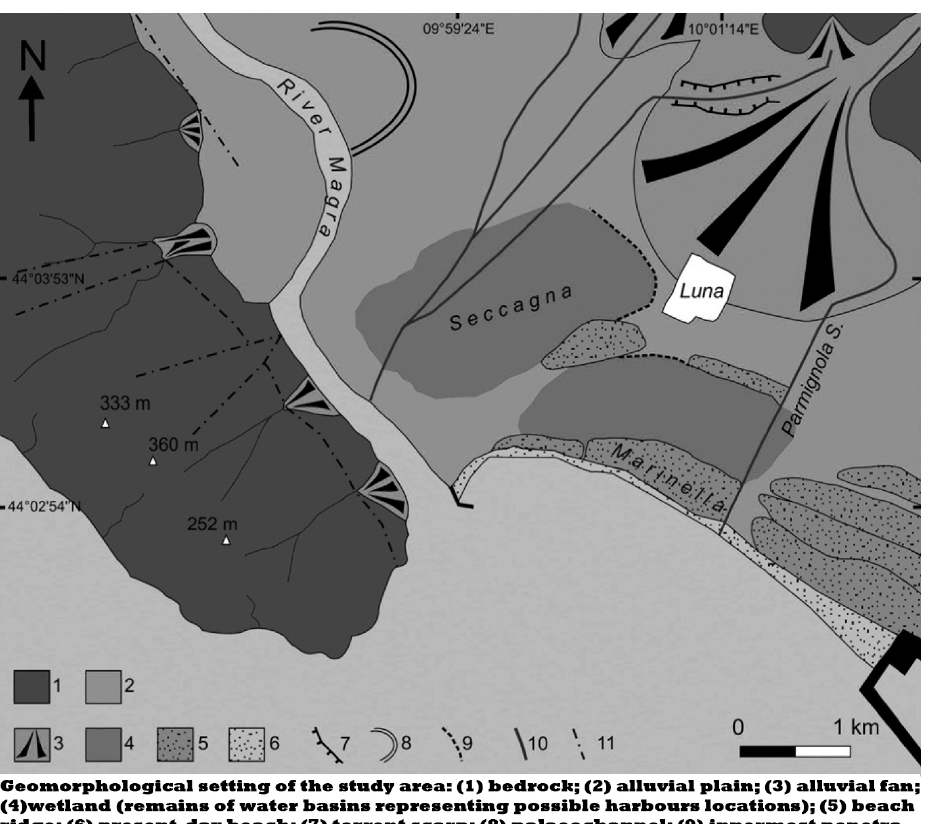
Figure 8: Geomorphological setting of the area near Lunae (Bini et al. 2012: fig.